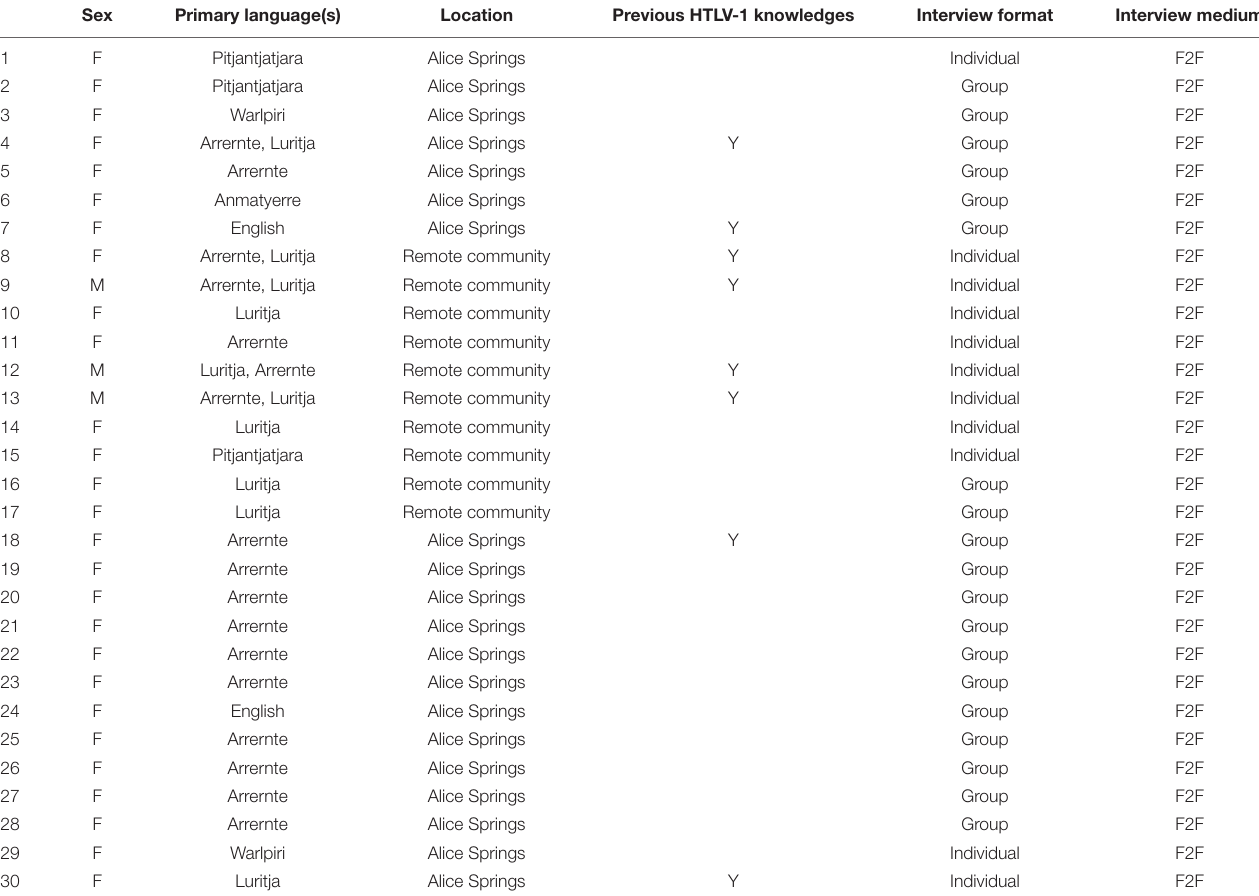
TABLE 1 | Profile of Aboriginal